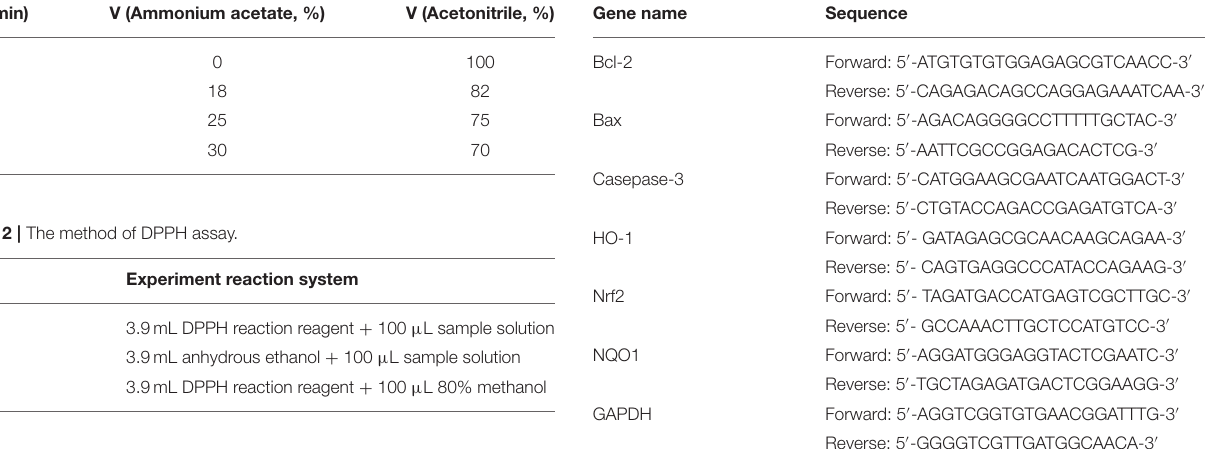
TABLE 3 | The method of ABTS assay.